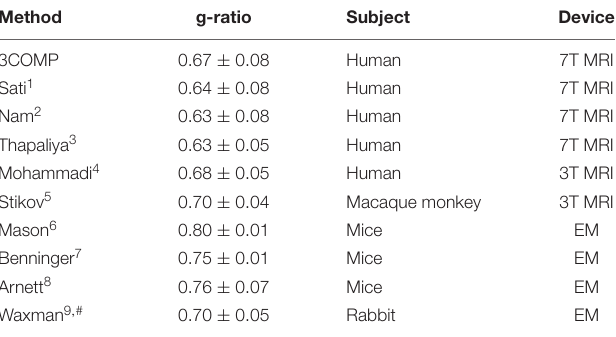
TABLE 4 | Summary of g-ratios calculated using the methods assessed here and those published previously for the corpus callosum in different species and using different